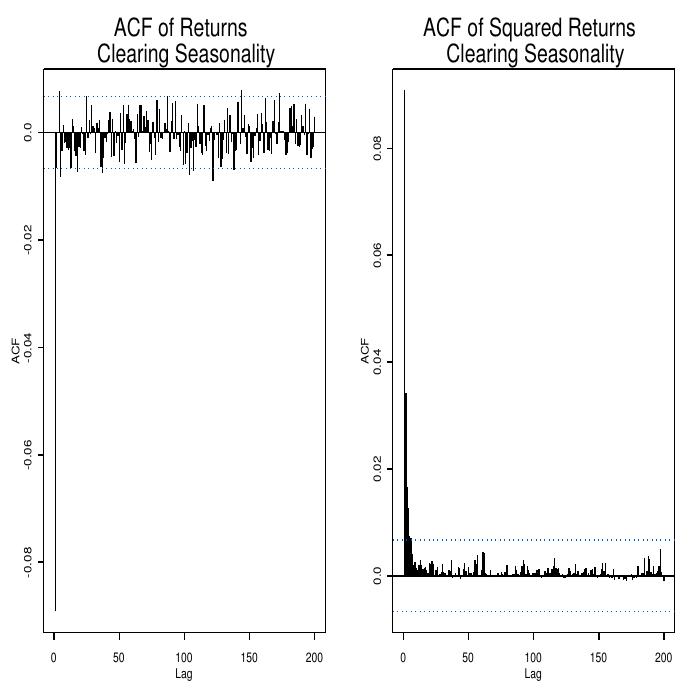
Figure 3. Autocorrelation functions of the Euro-Dollar returns and squared returns after seasonal